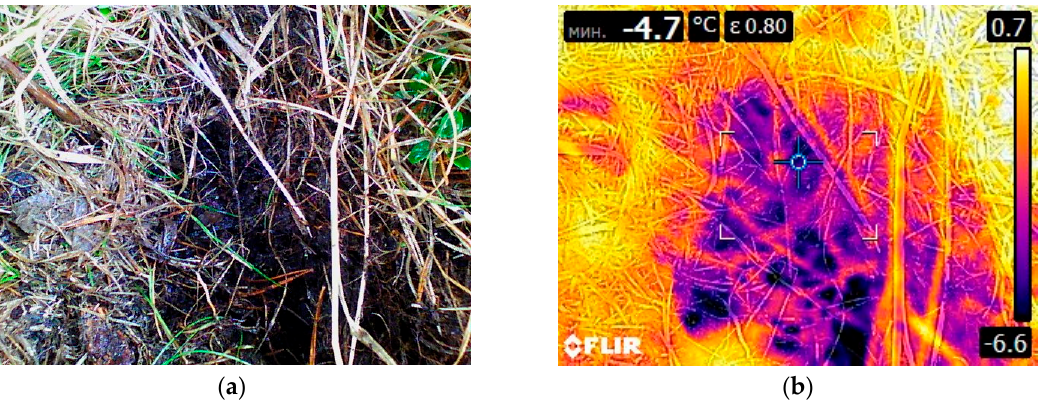
Figure 6. Photograph ( a ) and thermal image ( b ) of the soil under litter. The both images were received as single-step with the help of thermal imager Flir E5 under mean daily ambient temperature of +9.4 °C (data from the Olen’ya Rechka weather station).